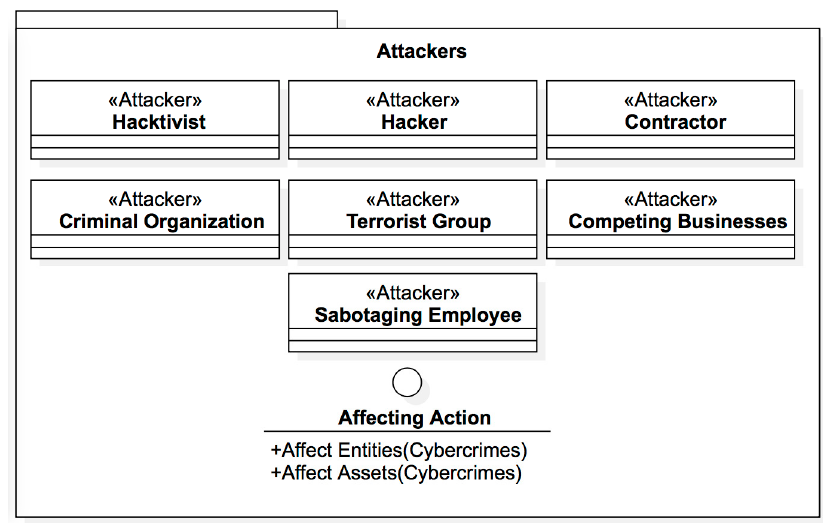
Figure 16. Attackers. Figure 16.